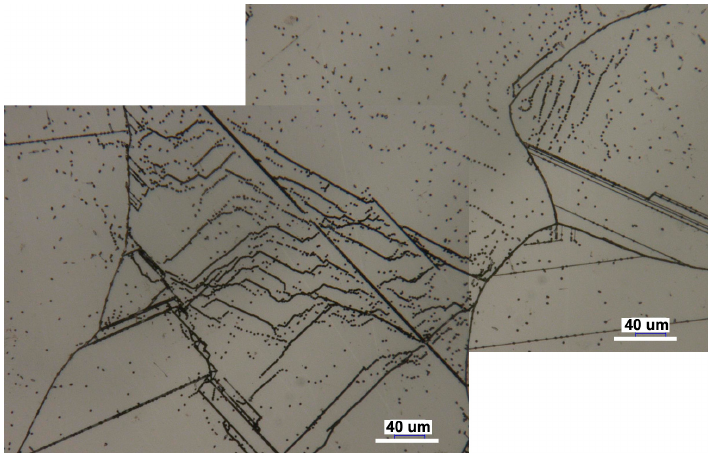
Figure 6. Image of slip dislocations in the minicrystallized regions. Two images were combined in this image to show a larger region.